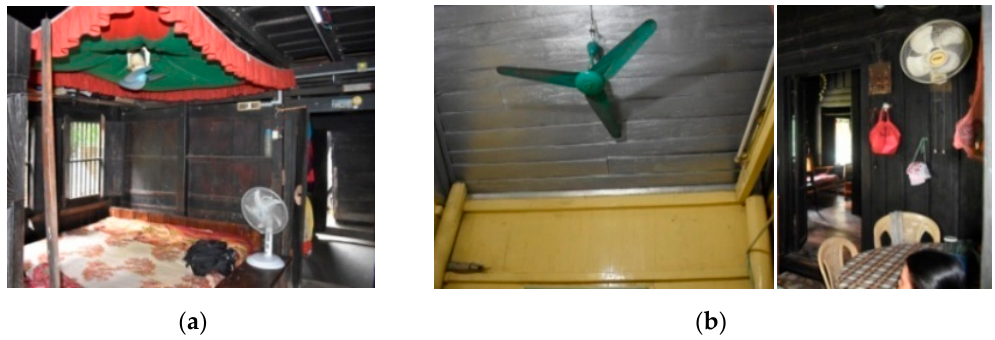
Figure 12. Installation of light and fan: ( a ) single/double-storied, ( b ) stilt timber house.